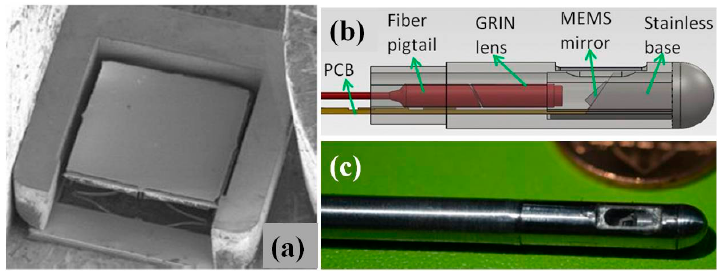
Figure 8. Electro-thermal MEMS swept-source common-path optical coherence tomography with an endoscopic imaging probe: ( a ) SEM image of the electro-thermal MEMS scanner; ( b ) schematic of the common-path OCT endomicroscope; and ( c ) photograph of the assembled probe adjacent to a penny for scale (Reproduced with permission from SPIE [62]).